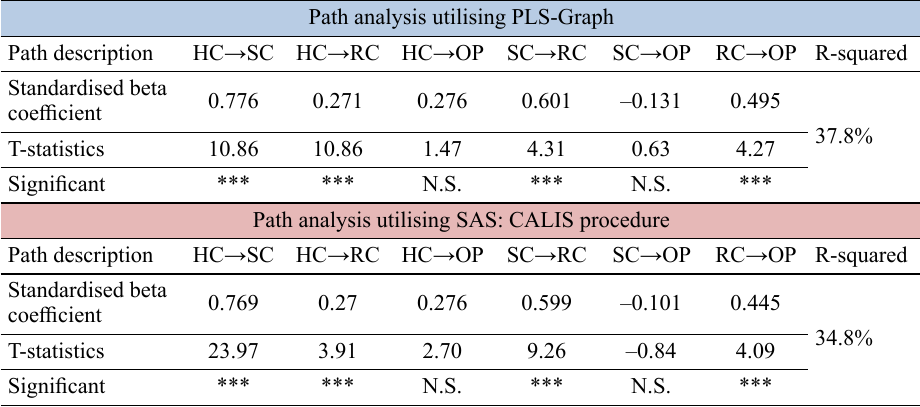
Table 3. Hypotheses testing: path modelling results for H1–H6 Path analysis utilising PLS-Graph